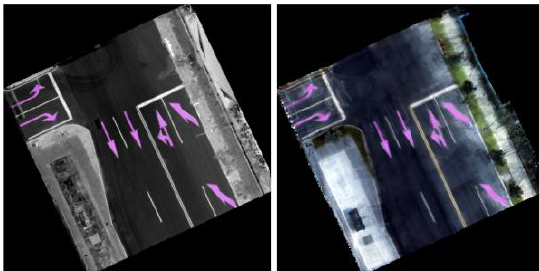
Figure 5. Sample annotated images from the initial training